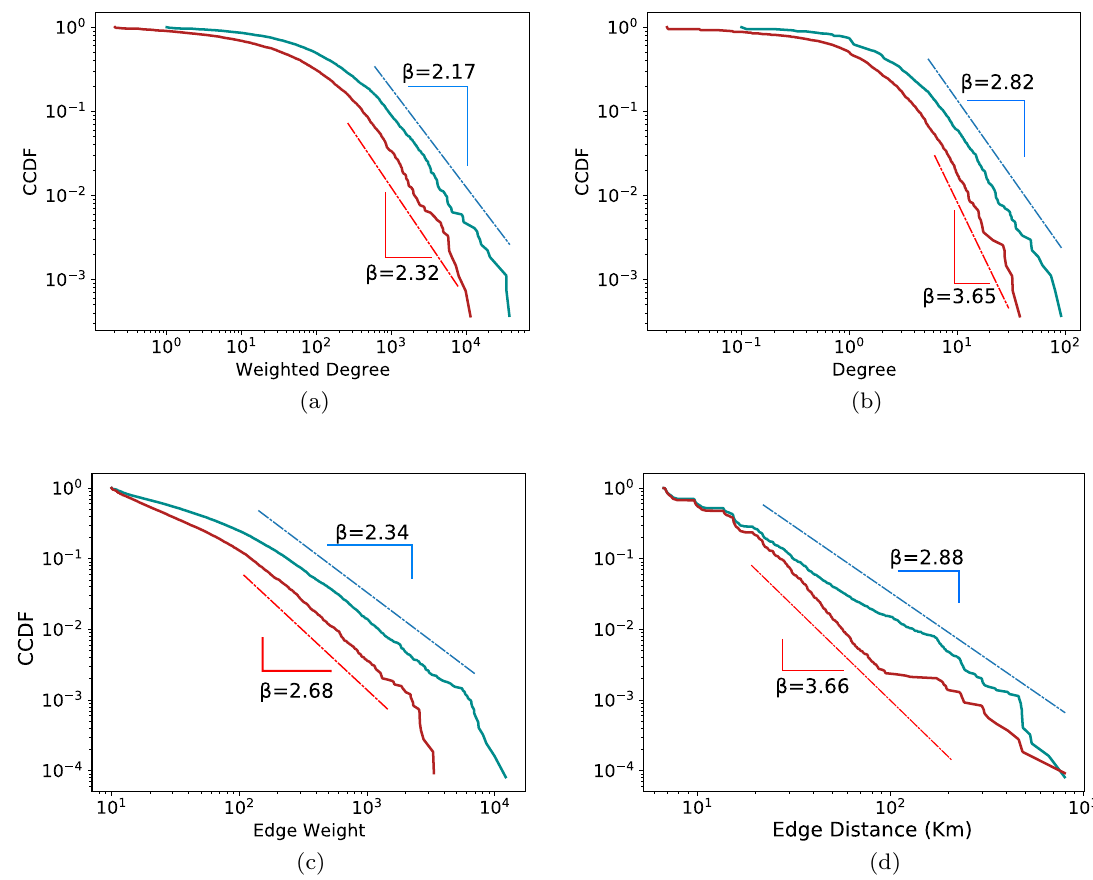
Figure 2. Comparison between pre-lockdown and lockdown of ( a ) weighted degrees, ( b ) Unweighted degree (for the degree distribution we also show a stretched exponential fit in the SI), ( c ) edge weights and ( d ) distances. Teal and dark red lines show the Complimentary Cumulative Distribution function (CCDF) of the weighted degrees, weights and distances before and during the lockdown, while the dashed lines show the stretched exponential (top) and power law fits (bottom) to the